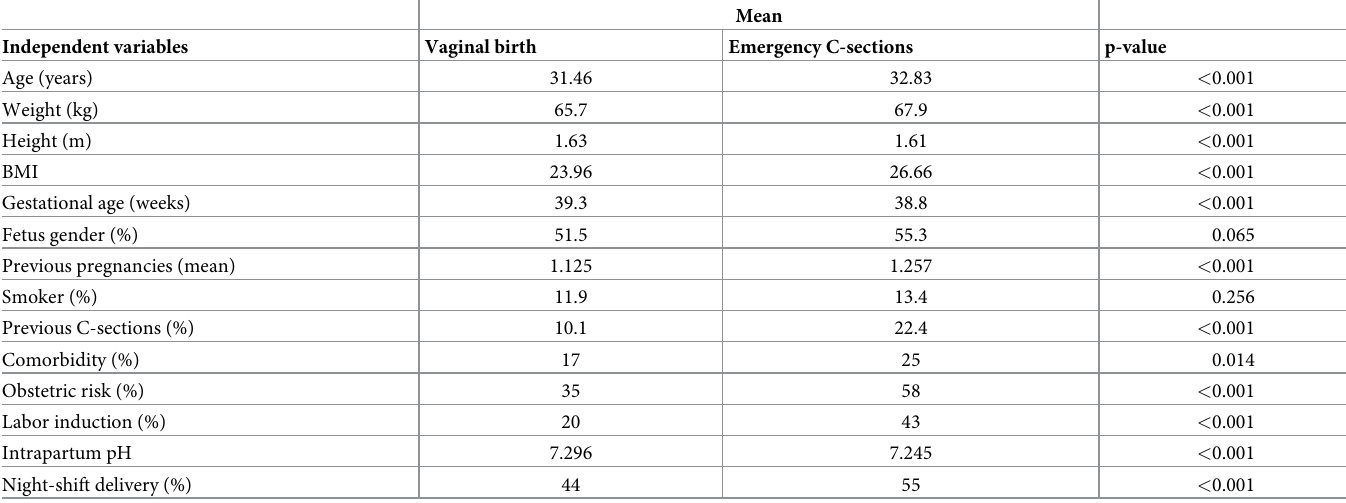
Table 4. Distribution of fetal, maternal, and contextual variables by delivery type.